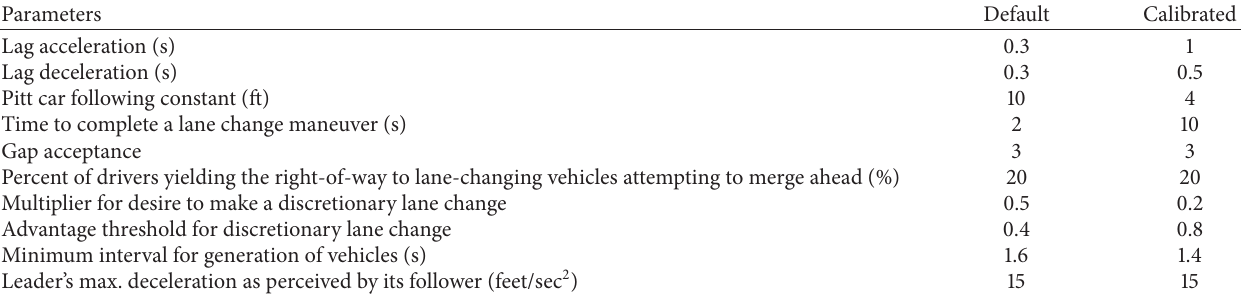
Table 6: Calibrated behavior parameters for the alternate routes choice simulation model by CORSIM.